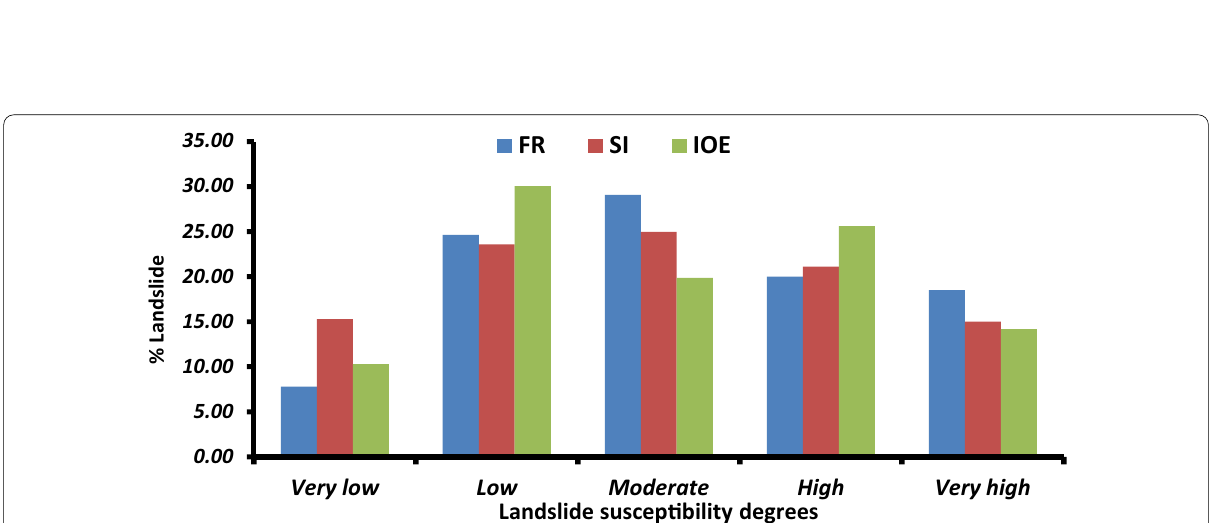
Fig. 7 The proportion (%) of landslide pixels for each susceptibility